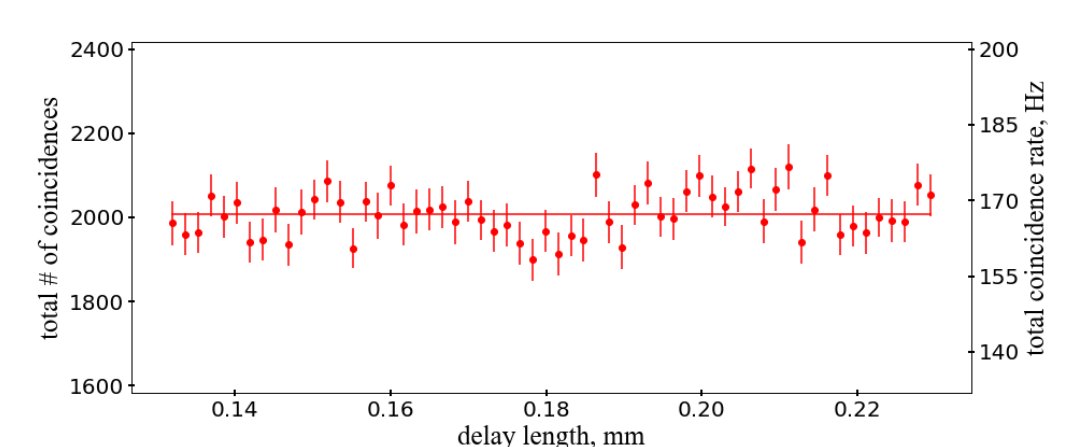
Figure 11. Sum of two-photon coincidence rates in single fibers and between two fibers as function of the